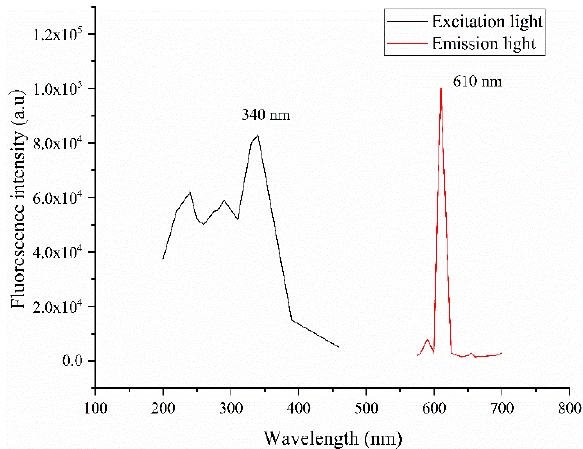
Figure 4. Excitation and emission spectra of the human chorionic gonadotrophin (HCG) test strip.